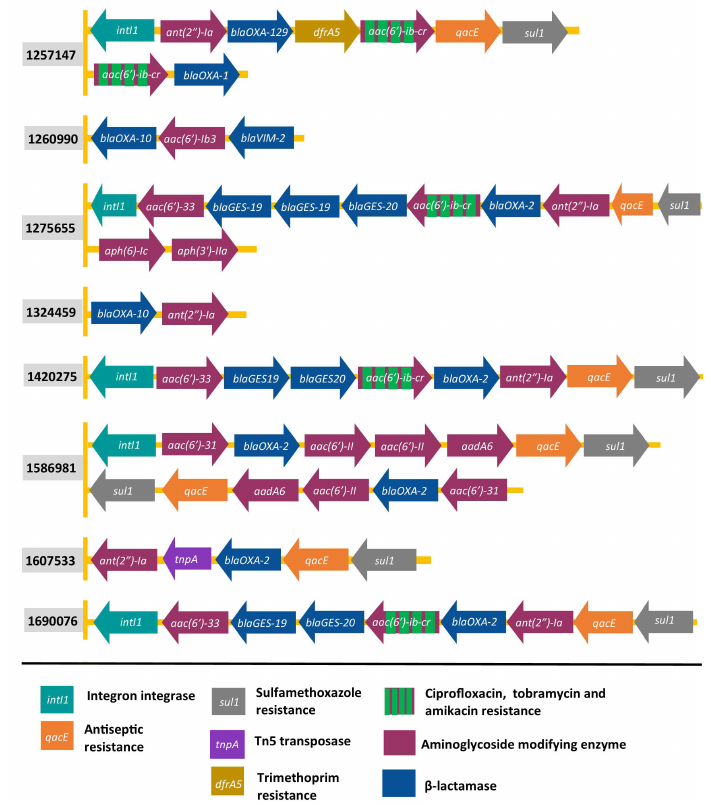
Figure 2. Examples of co-localisation of AME-encoding genes with genes that reduce susceptibility to other antimicrobial compounds. The presence and orientation of resistance genes in eight com- plete genome sequences was examined using MobileElementFinder. Each row represents a set of contiguous genes. Gene orientations are represented by arrowheads. Genes associated with transfer of mobile genetic elements ( intI1 , tnpA ) are also shown. A complete listing of acquired resistance genes is in Supplementary Table